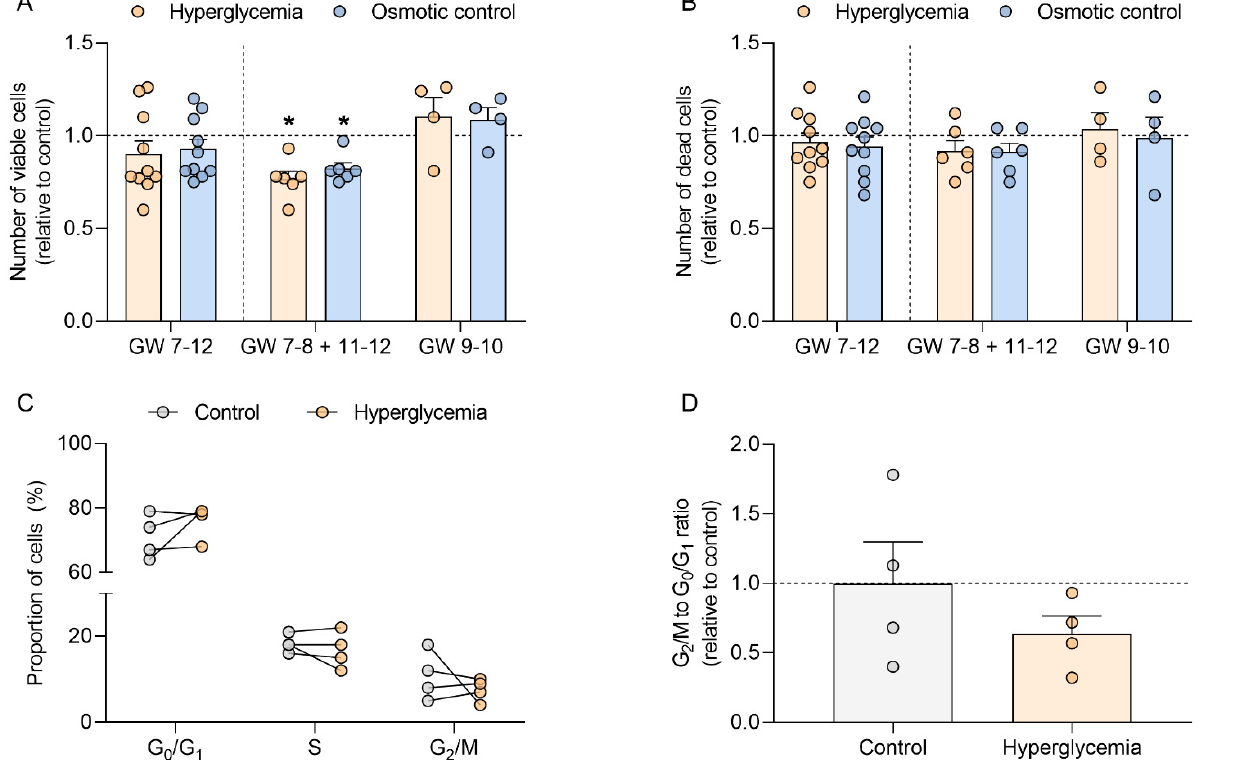
Figure 3. Hyperglycemia decreases viable cell count in human first trimester trophoblasts and does not affect cell death or cell distribution within the cell cycle. Primary human first trimester trophoblasts (gestational week (GW) 7–8, n = 8; GW 9–10, n = 4; GW 11–12, n = 2) were cultured in absence (control) or presence of 25 mM D-glucose (hyperglycemia) and 5.5 mM D-glucose + 19.5 mM D-mannitol (osmotic control) for 48 h. The numbers of viable ( A ) and dead cells ( B ) were counted in duplicates using the CASY TTC Cell Analyzer. The proportion of cells in the different phases of the cell cycle was determined by FACS ( C ). The ratio between the number of cells in G 2 /M and G 0 /G 1 was also calculated ( D ). Results were calculated relative to the control, arbitrarily set to 1, and presented as mean ± SEM ( A , B , D ) or expressed as percentage of cells ( C ). Statistical analysis used Wilcoxon signed rank test. * p < 0.05 vs. control.